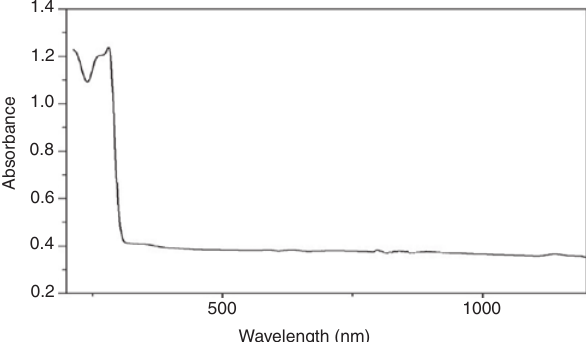
Figure 9: UV-Vis spectrum of PDTP.